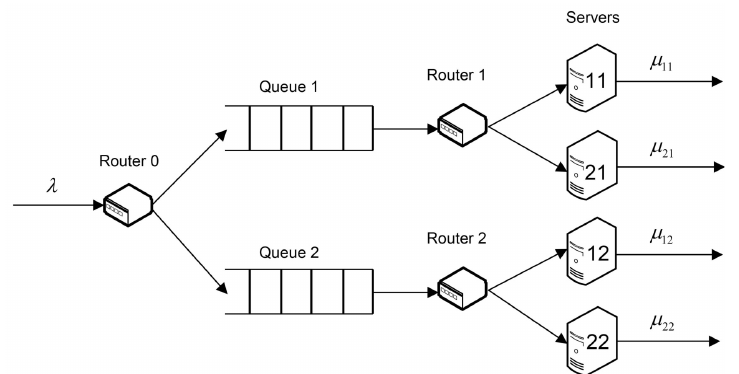
Figure 1. Controllable multi-server queueing system with heterogeneous servers and operating